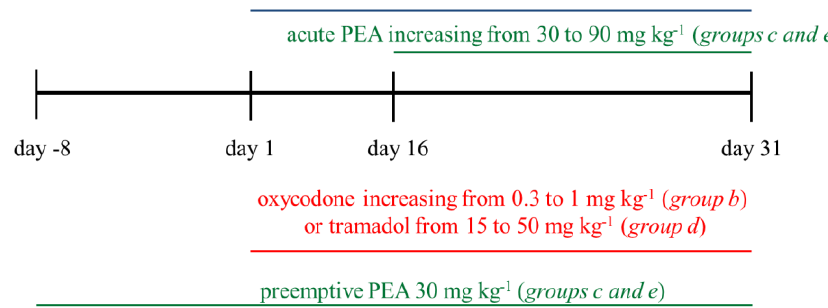
Scheme 2. Representative image of the second experimental treatment protocol.